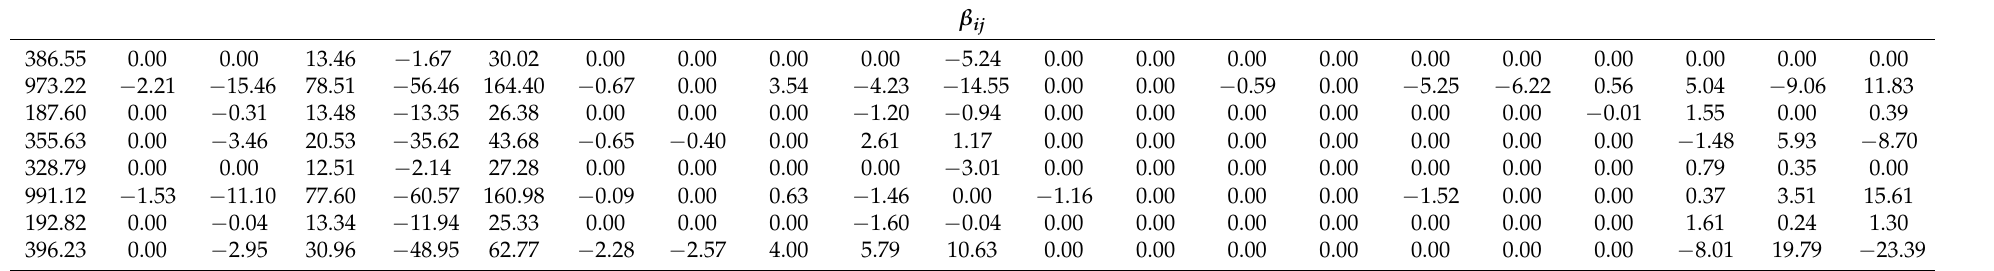
Table A5. Sensitivity of the thermal analysis parameters in Table